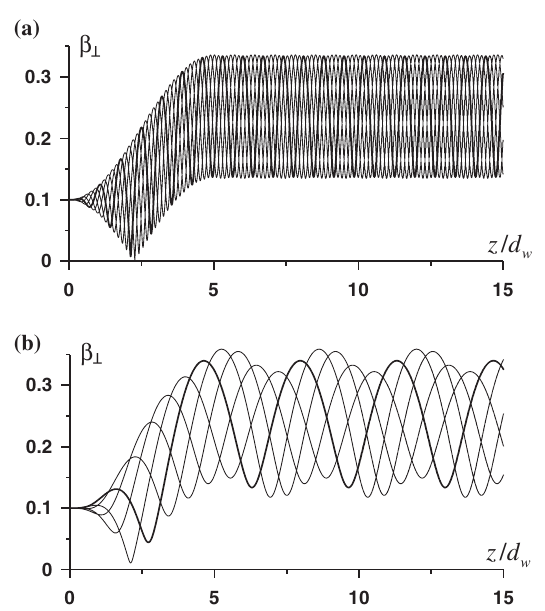
FIG. 4. Trajectory of electrons (cid:2) ? ð z Þ having the same absolute value of initial transverse velocity but different azimuthal angles to the axis at the wiggler entrance ( (cid:3) ¼ 3 , l ¼ (cid:2) 0 : 4 , (cid:4) ¼ 1 : 0 and (b) f=f (a) f=f cr w